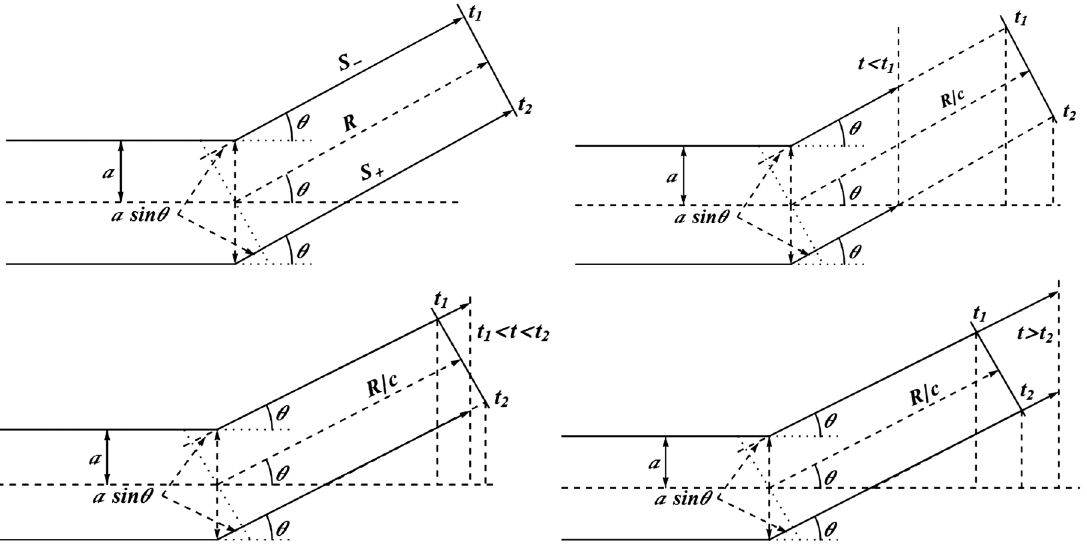
FIG. 4. Diffraction at the open end of the waveguide: steady-state regime (top left); dynamic regime: t < t 1 (top right); t 1 < t < t 2 (bottom left); t > t 2 (bottom